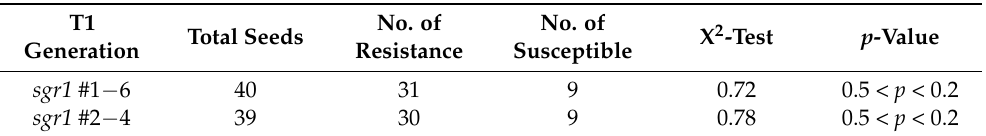
Figure 3. Phenotypes based on editing of the SlSGR1 gene in tomatoes. ( A ) Phenotypes of edited lines. ( B ) Fruit shapes in T 1 generation. ( C ) Selection of null segregant lines in T 1 generation via PCR analysis. Lanes with no band indicate T-DNA was removed. Table 2. Chi-square analysis for resistant and susceptible strains from T1 generation of SGR1 edited